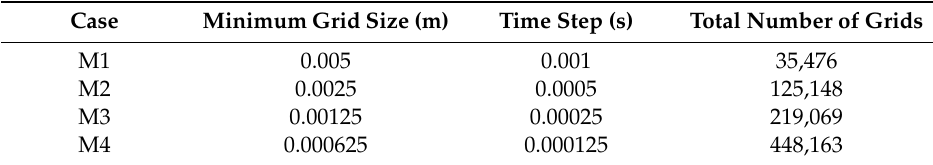
Table 1. Information for four different sets of simulations.